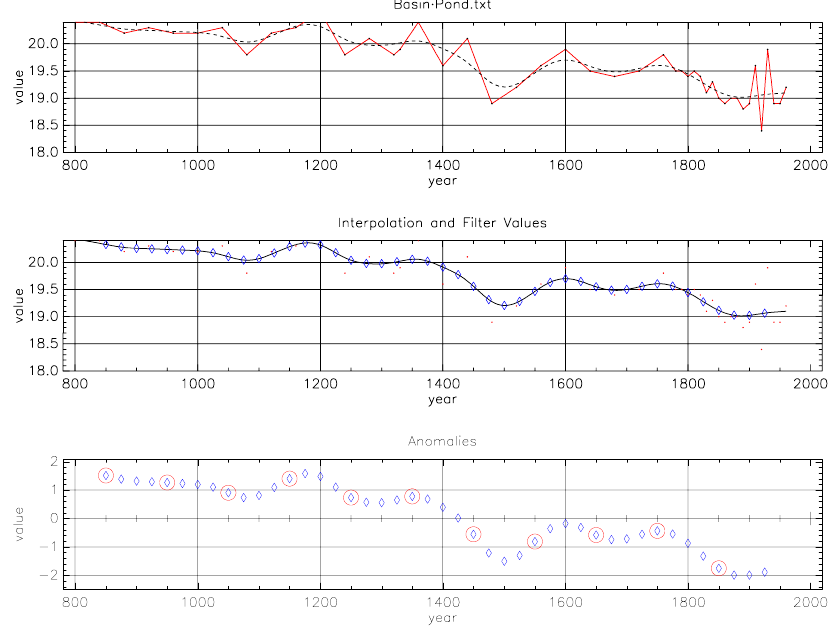
Fig. A2. An example illustrating the transformation of a non-annually resolved proxy record to a centennially resolved anomaly series. The top panel shows the raw data, in original units, with its spline fit. The middle panel shows the raw data (red dots) and the 45, 100yr, moving averages (overlap=25yr) between 850AD and 1850AD (blue diamonds). The bottom panel shows the 45, normalized (base period: 11th– 19th centuries) centennial filter values (blue diamonds) and the values of the 12 common centuries (red